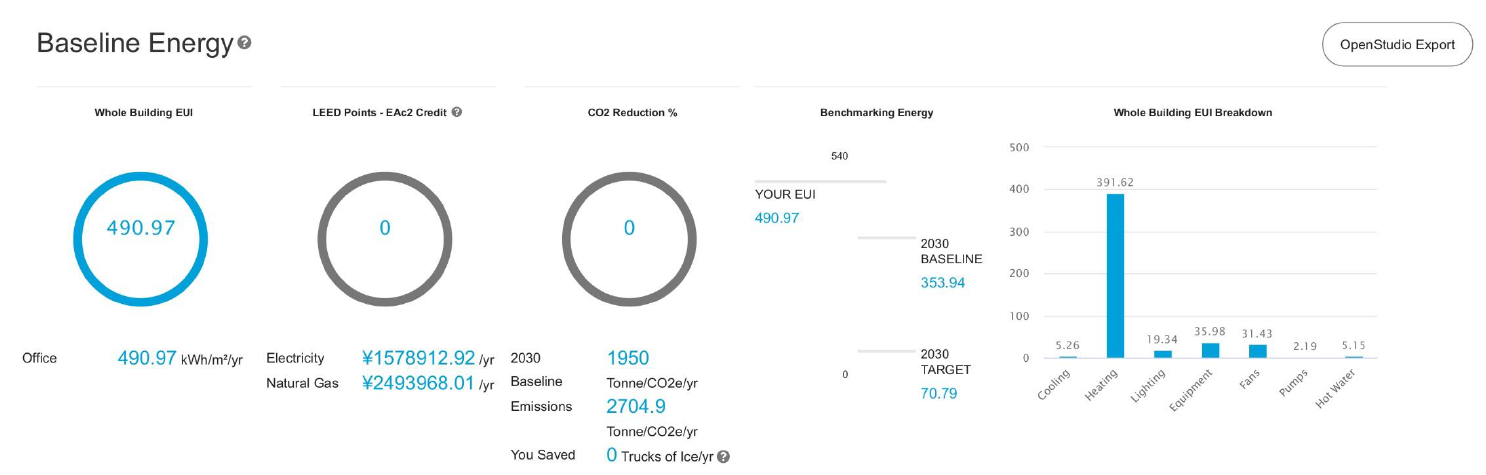
Figure A21. Zone 4-H Chamdo, Xizang (post-COVID-19 84% scenario).